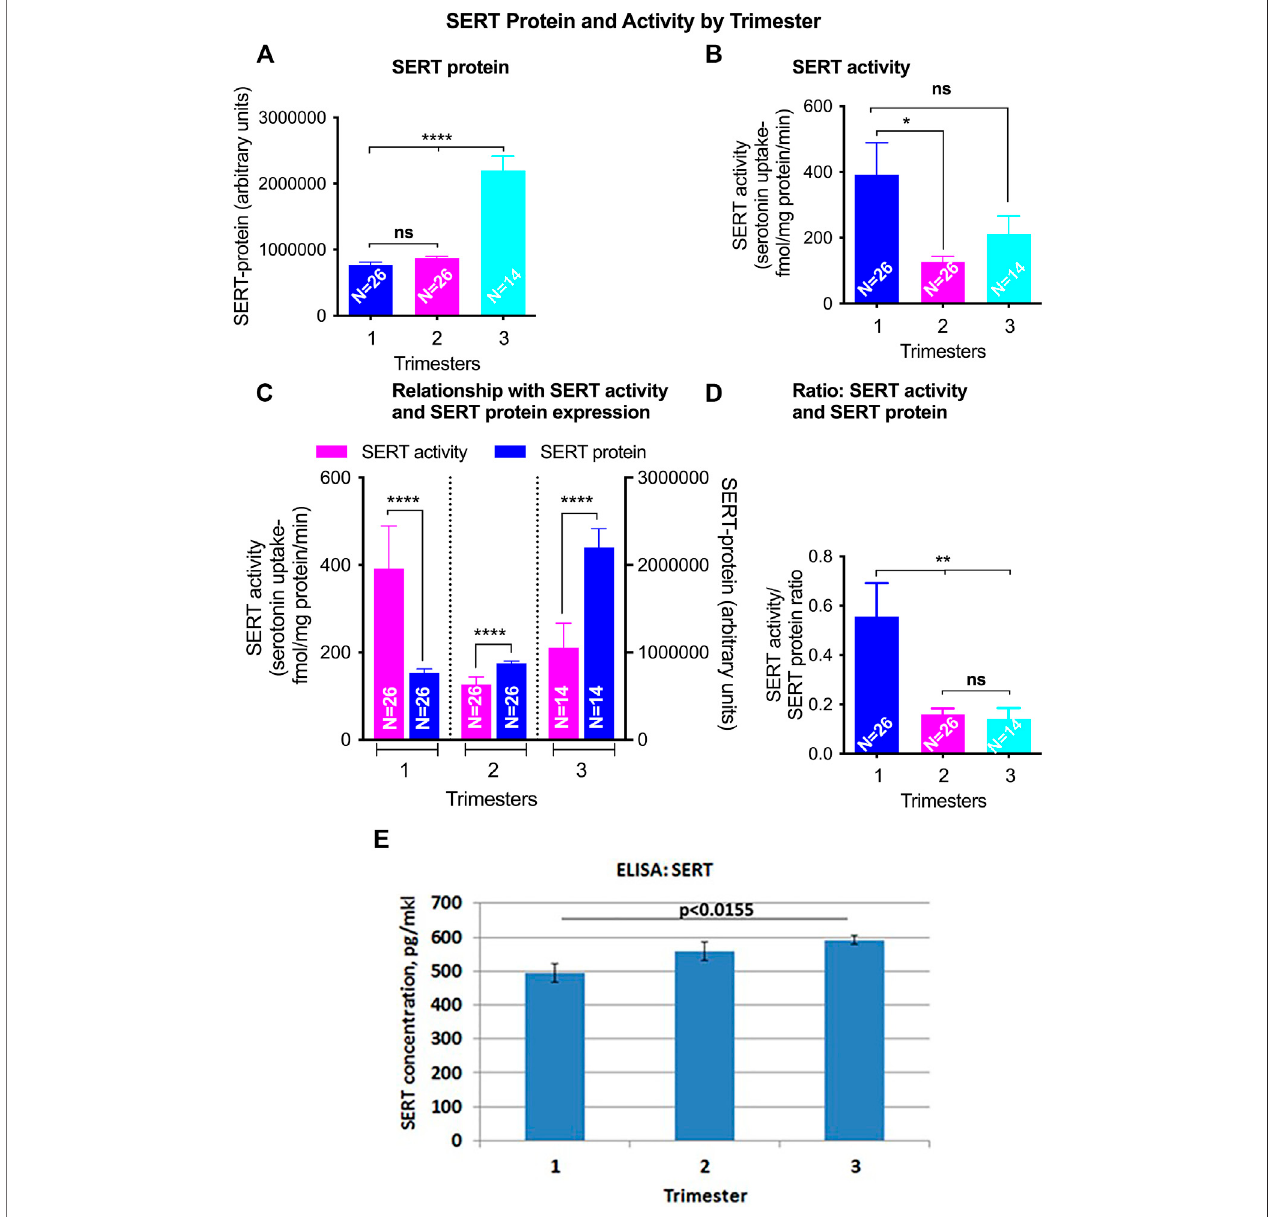
FIGURE 3 | GA differences in total SERT levels and activity in ROV placental vesicles. Total SERT quanti fi ed by Western blot in matched samples used for activity assays (A) . SERT mediated serotonin (5-HT) transport was quati fi ed using radiolabelled 5-Hydroxy-[ 3 H] tryptamine creatinine sulfate ([ 3 H]5-HT). Nonspeci fi c [ 3 H]5-HT uptake was de fi ned as the accumulation in the presence of 10 nM fl uoxetine and was subtracted from the total counts (B) . The relationship of SERT mediated 5-HT transportand SERT protein levels from thesamemembrane vesicles acrossgestationswasanalyzed (C,D) . Levels ofSERT transporterin ROVwerealso assayed by ELISA [ (E) ; pg/mkl of vesicles]. Symbols represent the following levels of statistical signi fi cance: * p < 0.05, ** p < 0.01, *** p < 0.001.